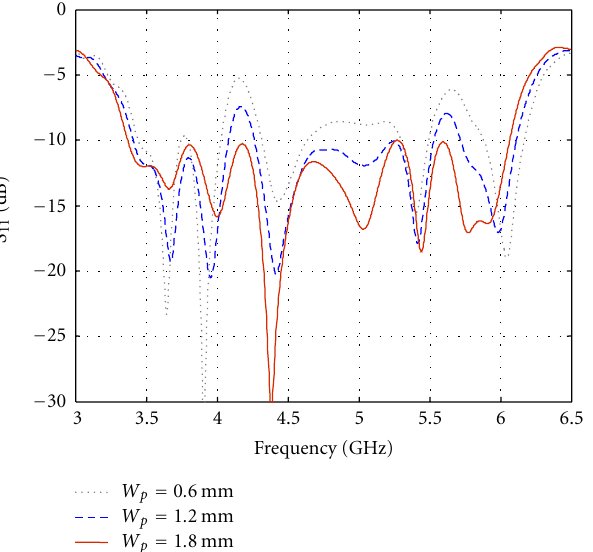
Figure 2: Reflection coe ffi cient of the MSA-MP for di ff erent W p .